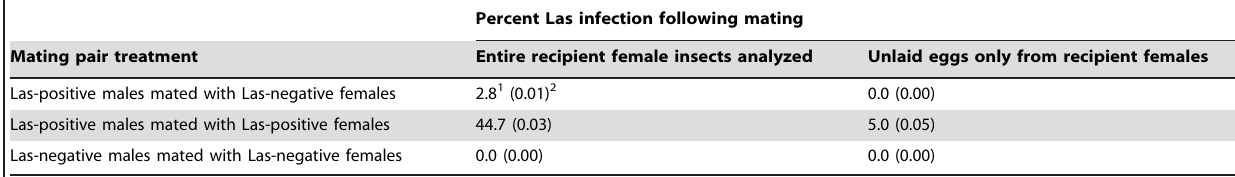
Table 3. Infection status of unlaid eggs from D. citri females that acquired Las during mating.